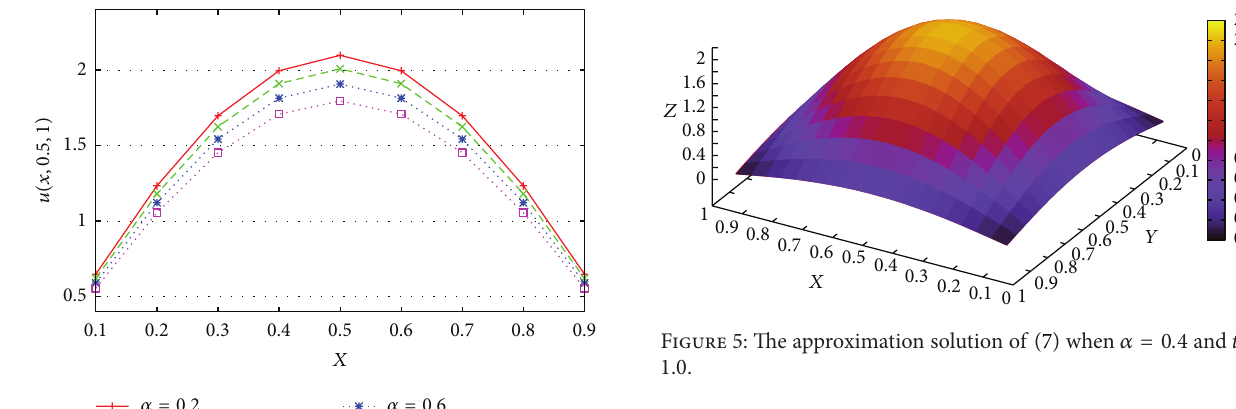
Figure 4: The numerical approximation whose transport is gov- erned by the TFDE (7) for various 𝛼 = 0.2 , 0.4 , 0.6 , 0.8 when 𝑦 = 0.5, 𝑡 = 1.0 .